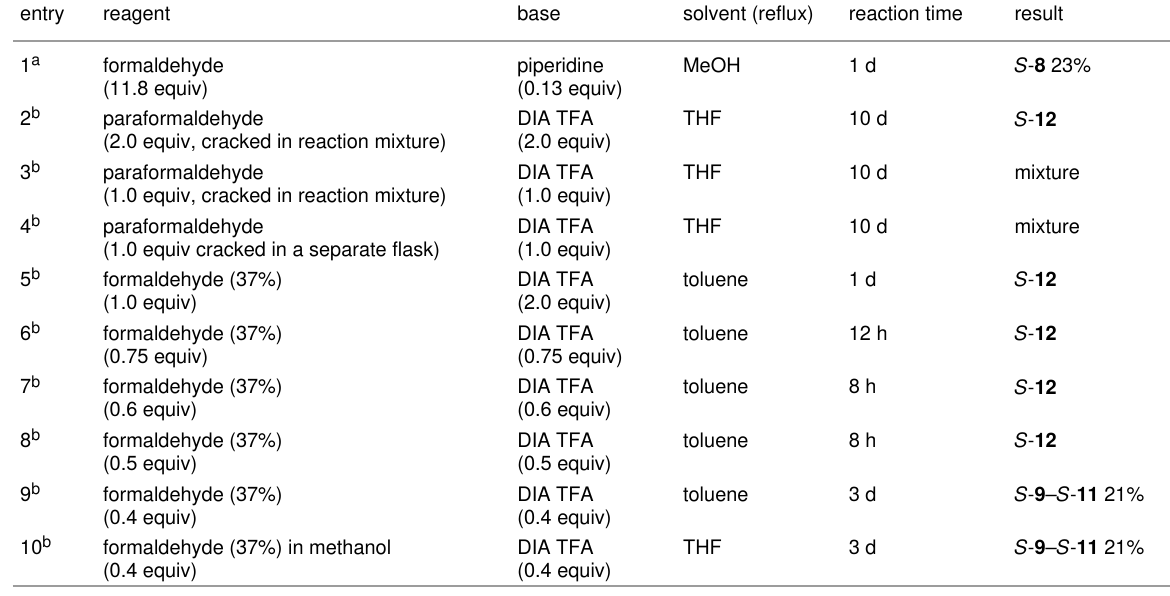
Table 1: Screening of different reaction conditions with the ( S )-Jørgensen’s organocatalyst S - 16 for the key Domino reaction, consecutive Mannich and intramolecular Diels–Alder reactions. DIA TFA: diisopropylammonium